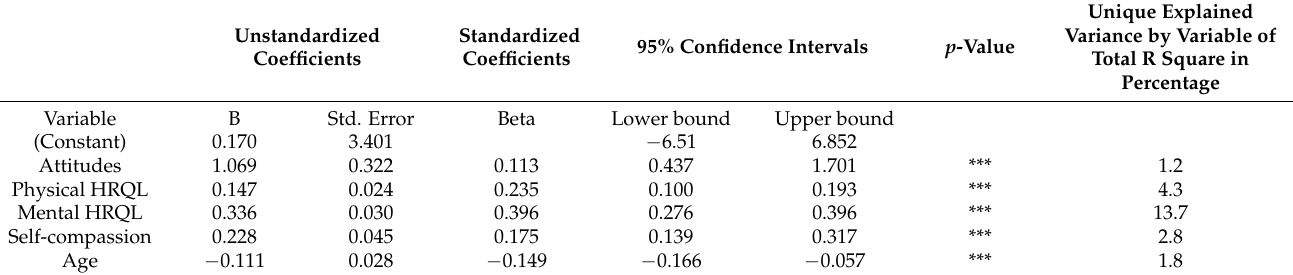
Table 3. Multiple regression coefficients for independent variables on life